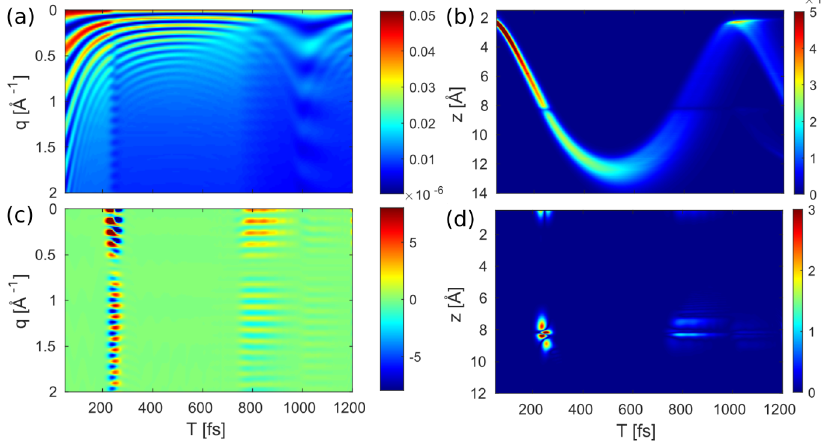
Fig 3. Selected diffraction images calculated by Eqs. 1 and 2. (a) Contribution from the exited state A 1 Σ (i). (b) Inverse Fourier transform of (a). (c) Inelastic contribution from the electronic coherence (v). (d) Fourier transform of